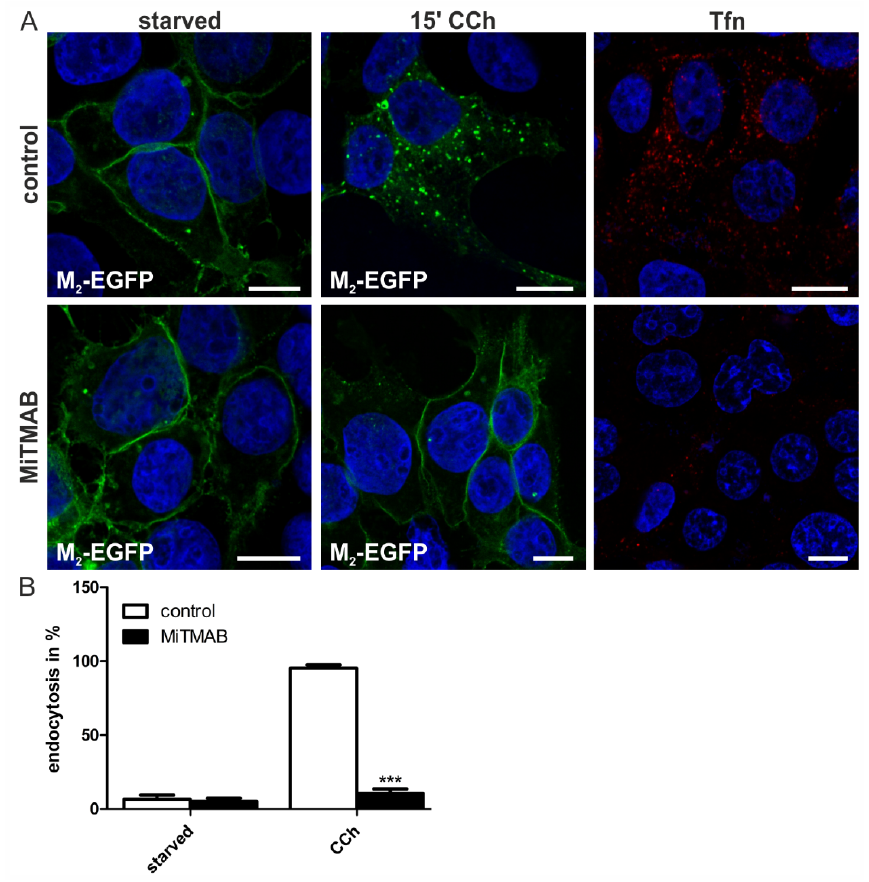
Figure 6. MiTMAB efficiently inhibits CCh-induced M 2 endocytosis. ( A ) HEK 293T cells were transfected with M 2 -EGFP, starved for 18 h in serum-free medium and pretreated with 30 μ M MiTMAB. Cells were left untreated, stimulated with 1 mM CCh for 15 min or incubated with Tfn546. Cells were fixed, and the nuclei were stained with DAPI (shown in blue). Scale bars: 10 μ m; ( B ) The fraction of cells displaying M 2 receptor internalization was quantified and is shown as the percentage of cells exhibiting intracellular M 2 . At least 100 cells were counted per condition. Results are shown as the mean ± SD.